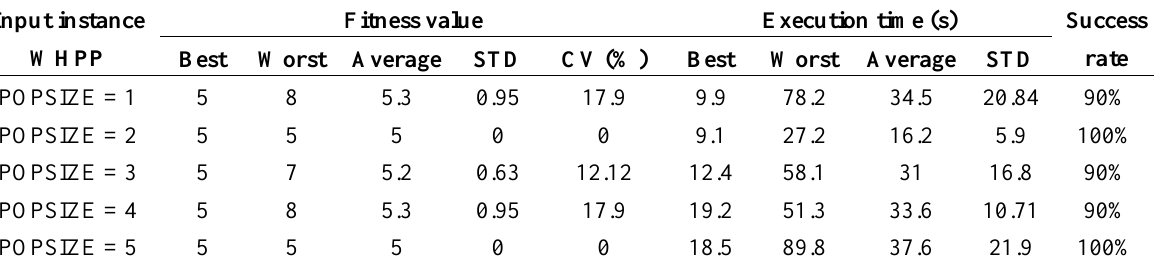
Table 21. Investigating the effect of population size for input instance, WHPP.